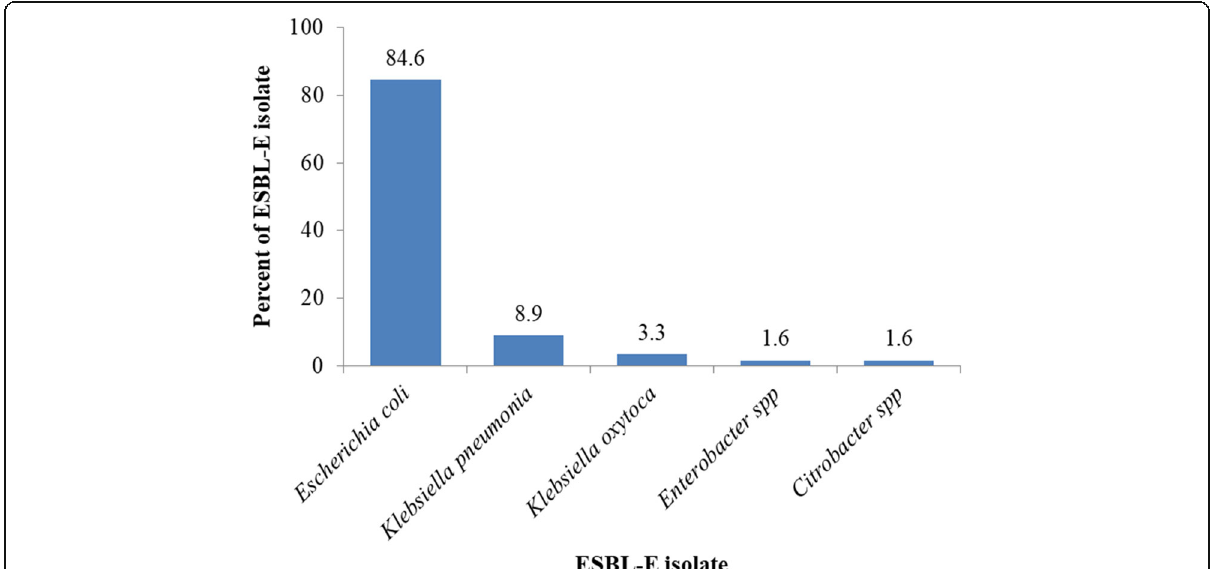
Fig. 1 Proportion of ESBL-E species isolated from pregnant women. The figure illustrates the distribution of specific ESBL-E isolates obtained from 182 pregnant women at Muhimbili National Hospital